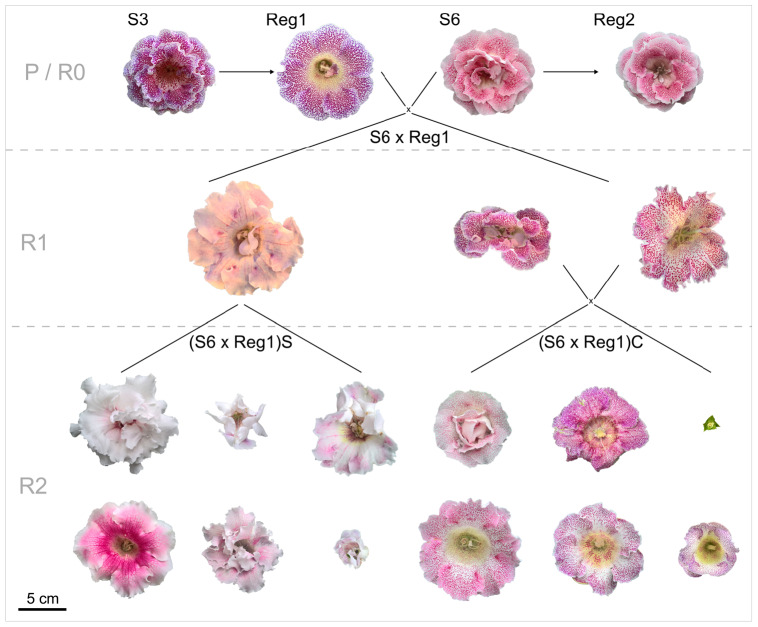
Schematic overview of flower morphology and plant breeding done with S. speciosa genotypes S3, S6 and their derivate Ri lines Reg1 and Reg2 (obtained from Arqua1 derived hairy root lines of S3 and S6, respectively). Variation in flower morphology of the R2 generation is representative per population (P, parental generation consisting of S3 and S6; R0, generation consisting of the Ri lines Reg1 and Reg2; R1, F1 generation obtained from a cross between a parental genotype and an Ri line; R2, F2 generation obtained from a cross between rol+ R1 genotypes; S, selfing; C, cross, scale bar = 5 cm).